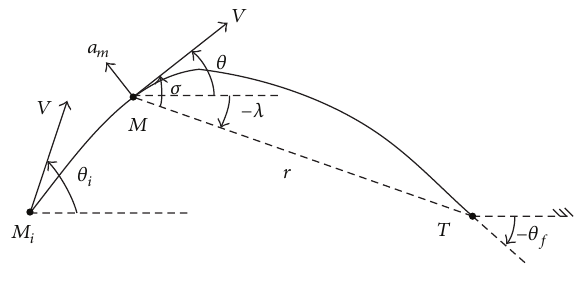
Figure 1: Engagement